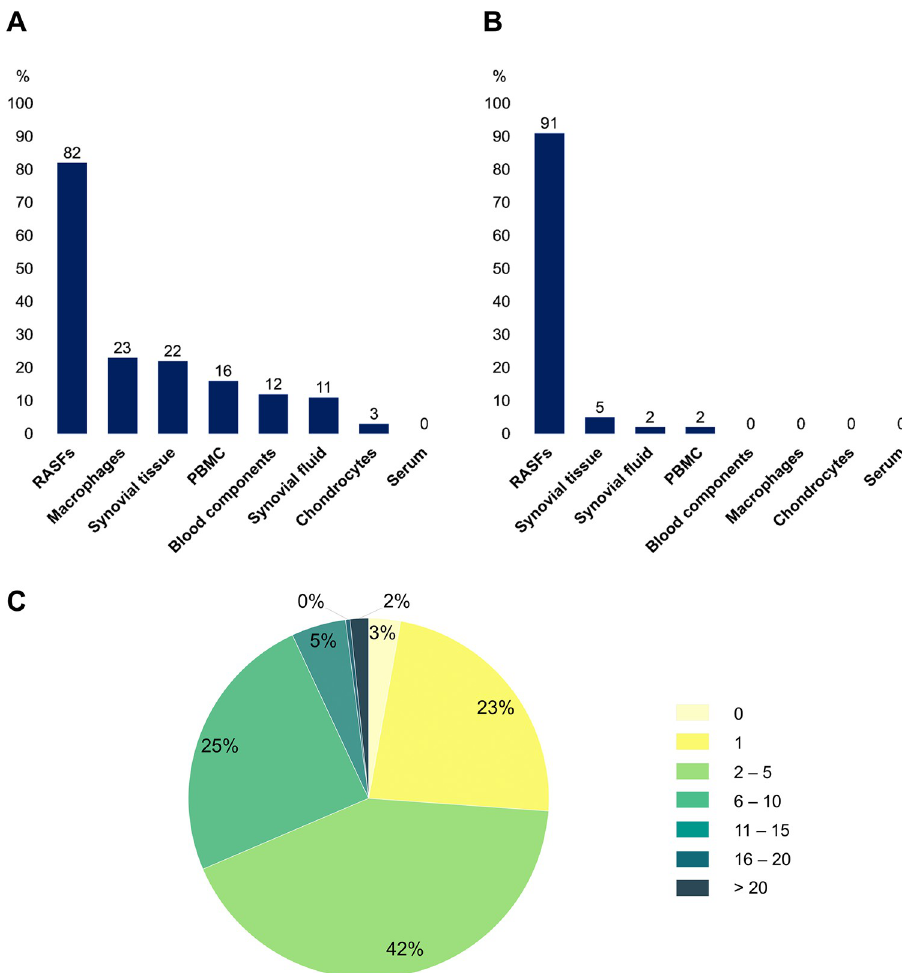
Fig 2. Statistical analysis of the RASF model. (A) Distribution of the RASF model’s cellular specificity. (B) Distribution of the RASF model’s cellular specificity when only exclusive components are considered. (C) Annotation score’s distribution among the RASF model’s